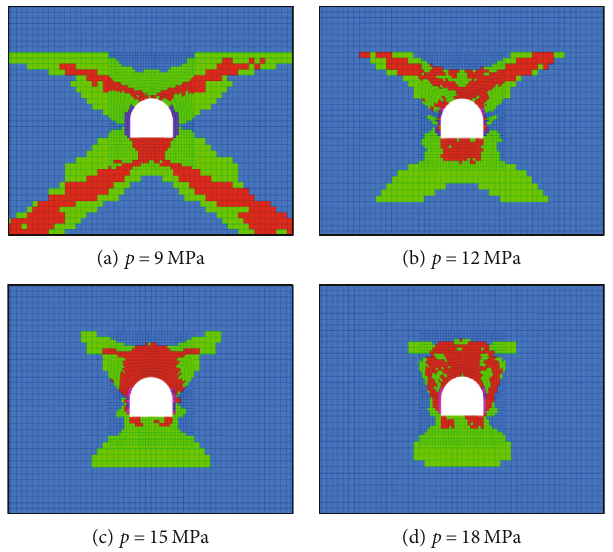
Figure 9: The distribution of plastic zone under various spherical stresses.